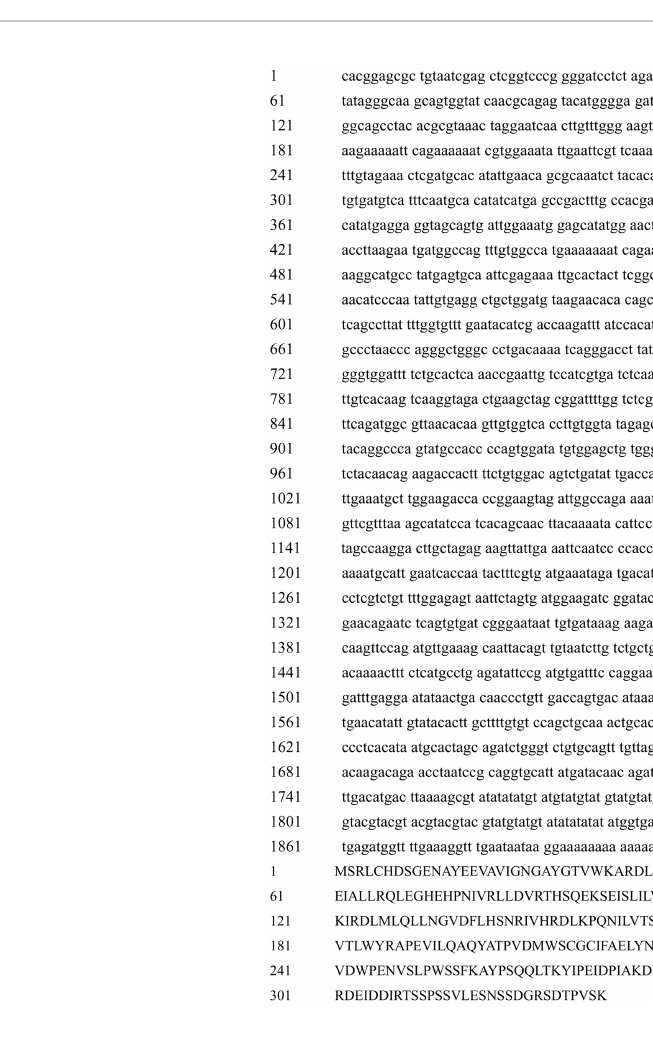
FIGURE 1 | The nucleotide and amino acid sequences of Hc-CDK6